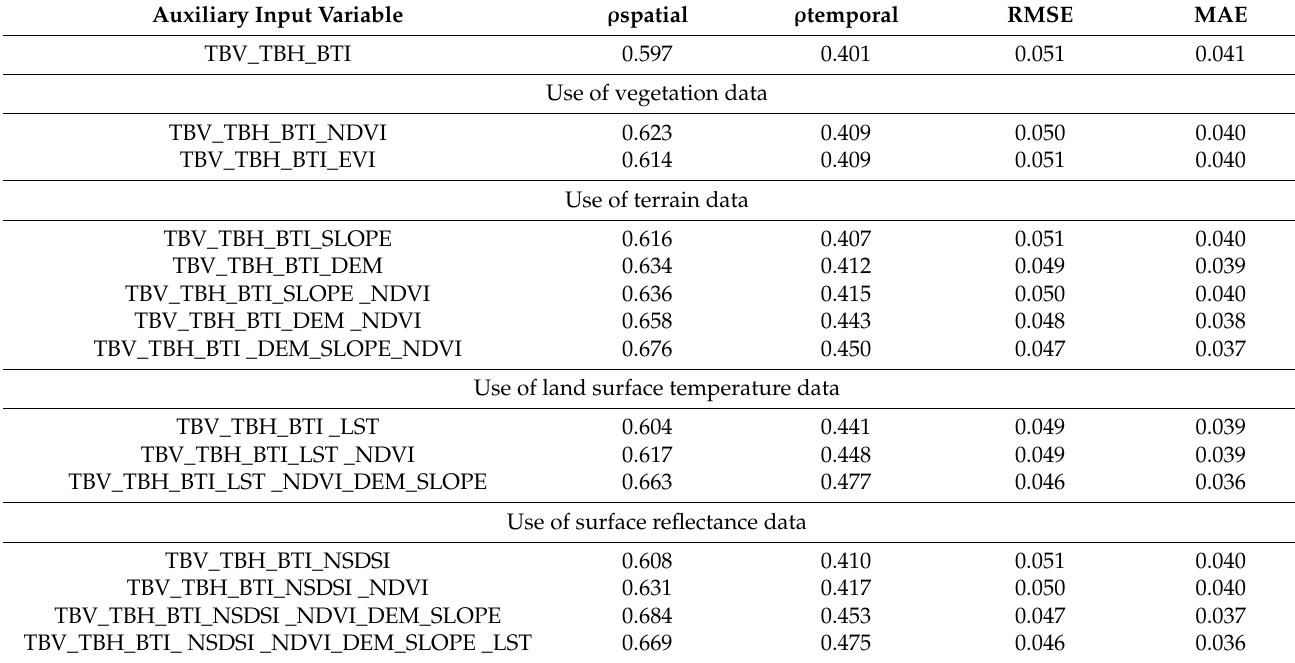
Table 5. Average quality index of soil moisture calculated from auxiliary input variables compared with data from CLDAS. Auxiliary Input